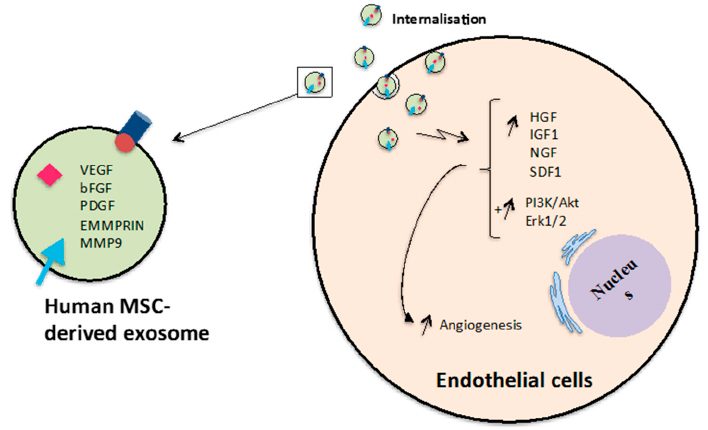
Figure 7. Promotion of angiogenesis by MSC-derived exosomes. Exosomes released from human MSCs can induce expression of genes and activate PI3K/Akt and Erk1/2 signalling pathways in endothelial cells leading to promotion tube formation and newly formed vessels.